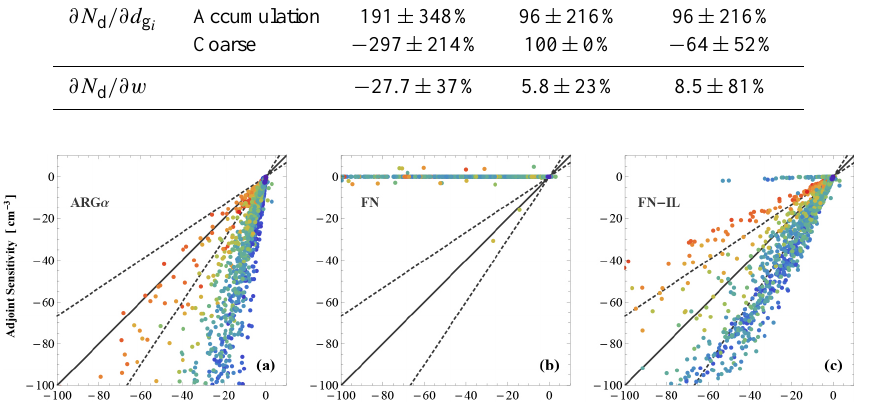
Fig. B1. Comparison between the sensitivity to hygroscopicity for coarse mode aerosol, ∂N d /∂κ a model simulations and (a) ARG α , (b) FN, and (c)